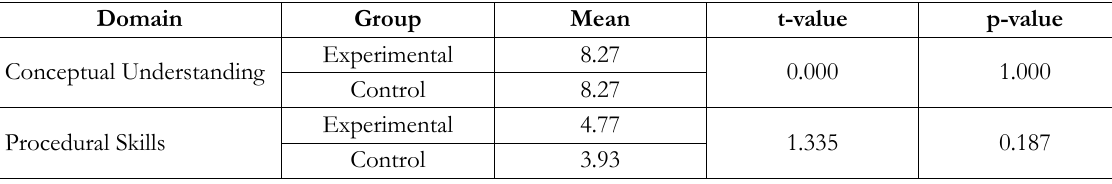
Table 3. Significant Difference in the Pretest Performances of the Experimental and Control Groups